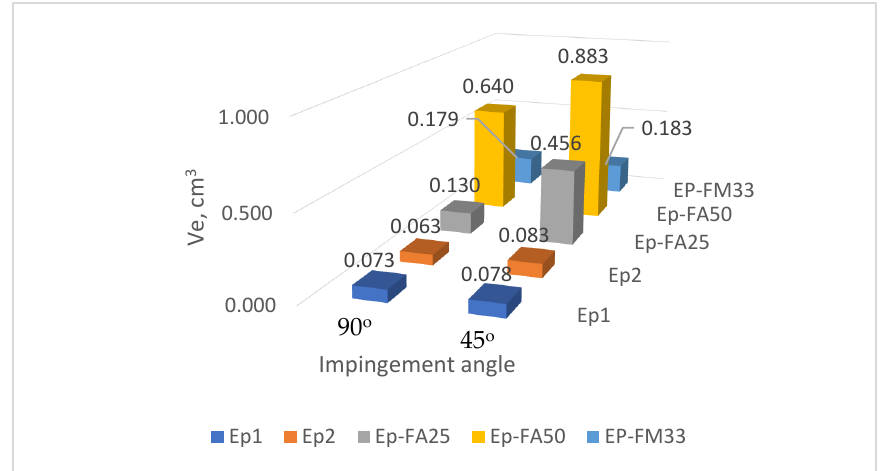
Figure 7. Compound wear at 180 °C at 90° and 45° impingement angles.